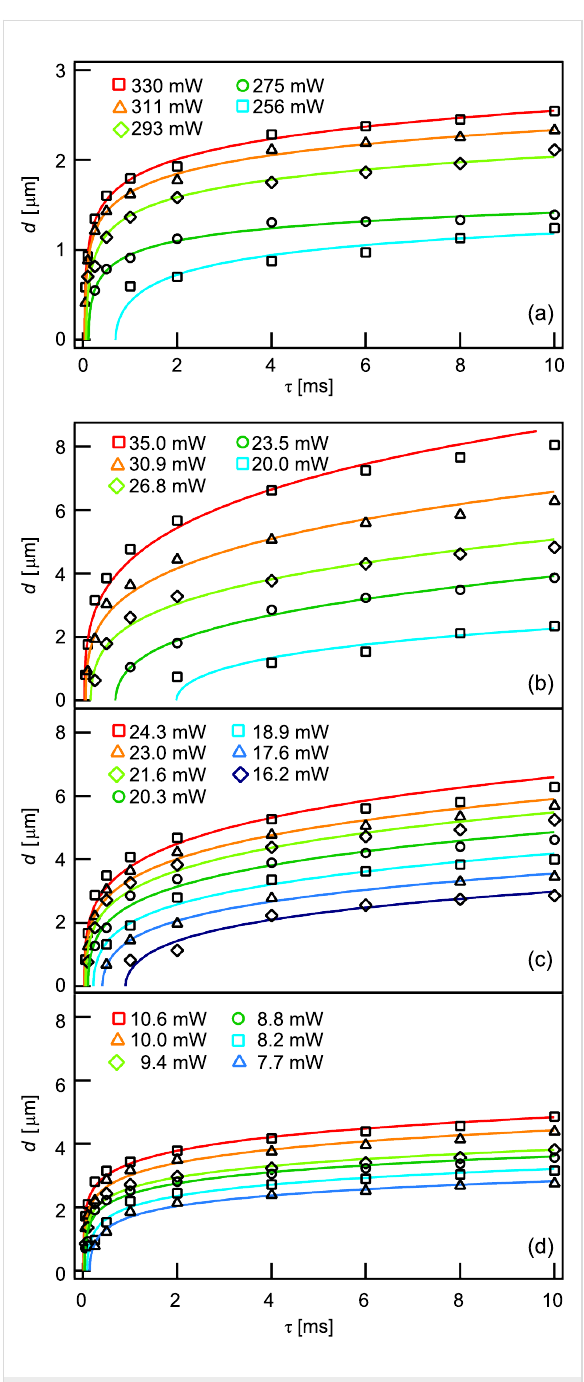
Figure 6: Dependence of the structure diameter d on the incident laser power P and the pulse length τ of HDT-SAMs on (a) Au/Si substrates with a 30 nm Au layer, (b) Au/glass substrates with a 50 nm Au layer, (c) Au/glass substrates with a 30 nm Au layer and (d) Au/glass substrates with a 10 nm Au layer. The lines are guides for the eyes